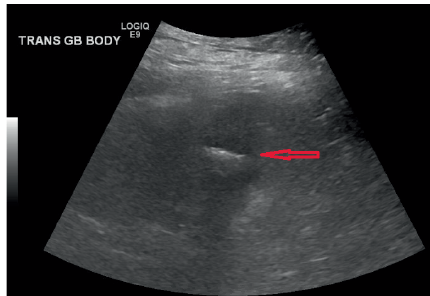
Figure 4: Contrast CT scan depicting cholecystoduodenal fistula (short red arrow).